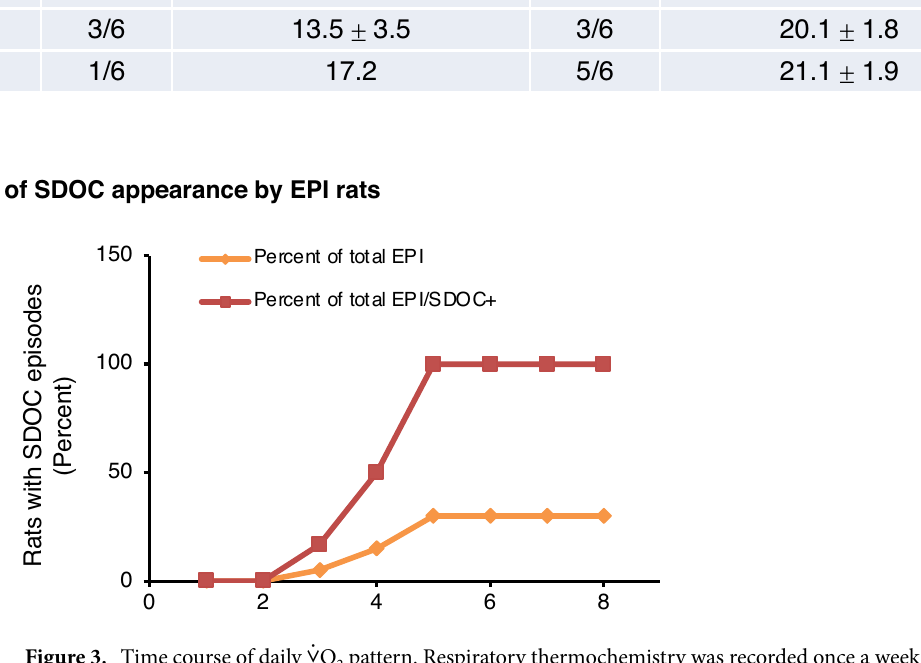
Figure 3. Time course of daily ⩒ O 2 pattern. Respiratory thermochemistry was recorded once a week for each rat, from the 1st to the 8th week post-SE. ( A ) Daily ⩒ O 2 was calculated for each group (control rats (n = 8), EPI/SDOC− rats (n = 14), EPI/SDOC + rats (n = 6)) from 1 to 8 weeks post-SE. ( B ) Daily ⩒ O 2 of animals was calculated at 3–4 weeks post-SE in animals identified as EPI/SDOC + rats or at 1–2 weeks post-SE in animals pending identification as EPI/SDOC + rats. Paired comparison of daily ⩒ O 2 over weeks showed statistical significance with only 1–2 weeks post-SE. Results are expressed as mean ± SEM of ⩒ O2, *P < 0.05; **P = 0.01 in comparison to daily ⩒ O 2 at 1–2 weeks post-SE. ( C ) The first SDOC was detected in one rat (1/20) during the 3 rd post-SE week. The maximum number of EPI rats exhibiting SDOCs (EPI/SDOC + , 30%) was reached by the end of the 5th week post-SE. The proportion of EPI/SDOC + rats was expressed in percent of the total number of rats developing epilepsy (yellow curve) or in percent of the total number of rats presenting with SDOCs by the end of the 8th week post-SE (red